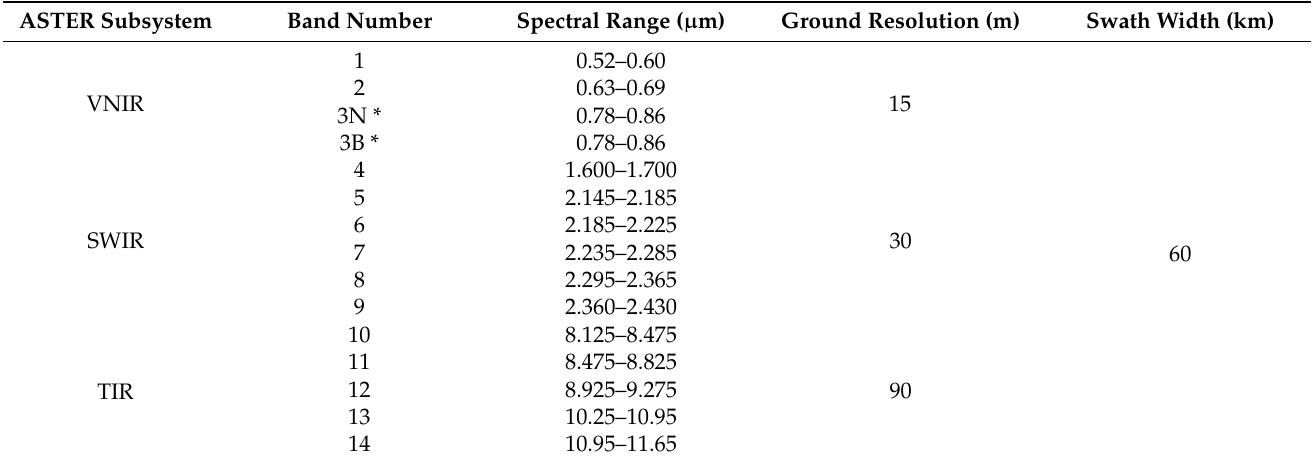
Table 1. The technical characteristics of ASTER data [33,73,74].